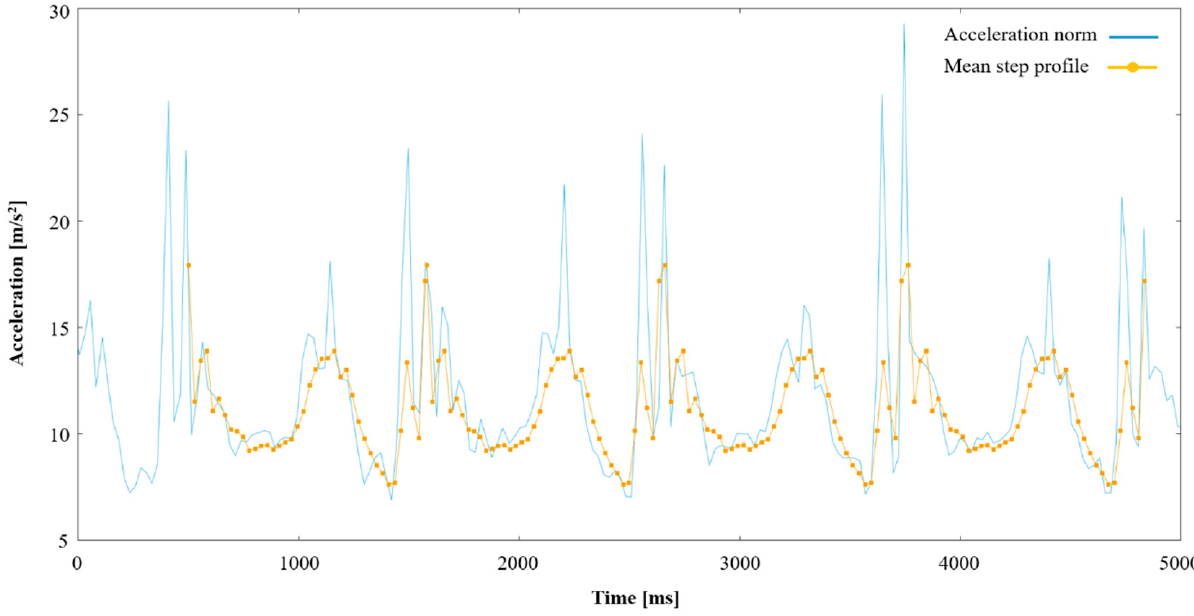
Figure 2. Acceleration norm during unobstructed walk presented together with an overlay of the calculated mean step profile.